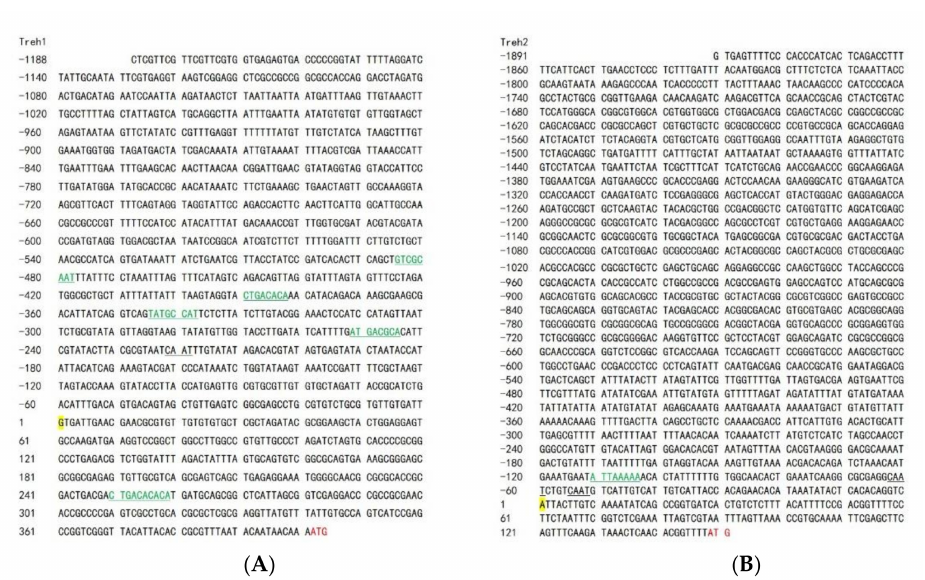
Figure 3. Analysis of the transcription start site of the cloned section. ( A ) Analysis of the PxTreh 1 transcription start site. ( B ) Analysis of the PxTreh 2 transcription start site. The inclined sequence was obtained using 5’ RLM-RACE. Yellow Nucleobase indicates the transcription initiation site, whereas the black underlined section is the cis -acting element CAAT box. The green and underlined sections are transcription factor binding sites. Skeleton alphabet sequence from RACE. RLM-RACE, RNA ligase-mediated rapid amplification of cDNA